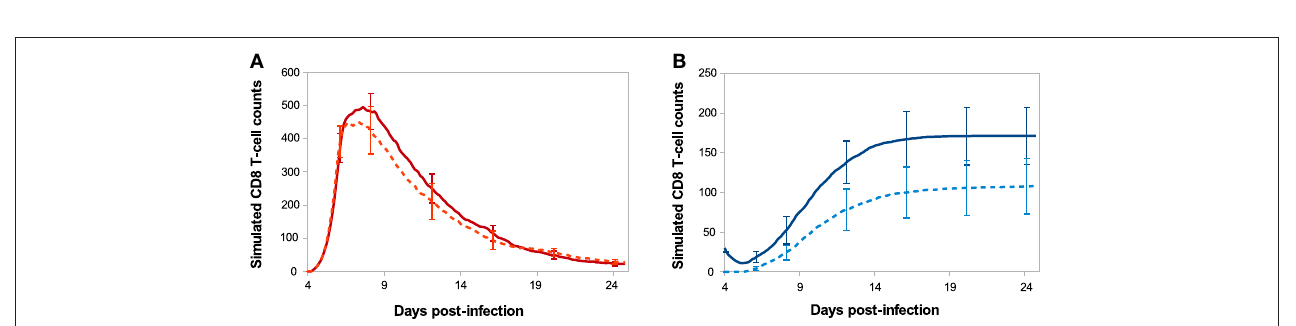
FIGURE 7 | Number of (A) activated/effector and (B) memory CD8 T-cells during in silico primary (dashed line) and secondary (full line) responses. Mean ± standard deviation over 10 simulations.